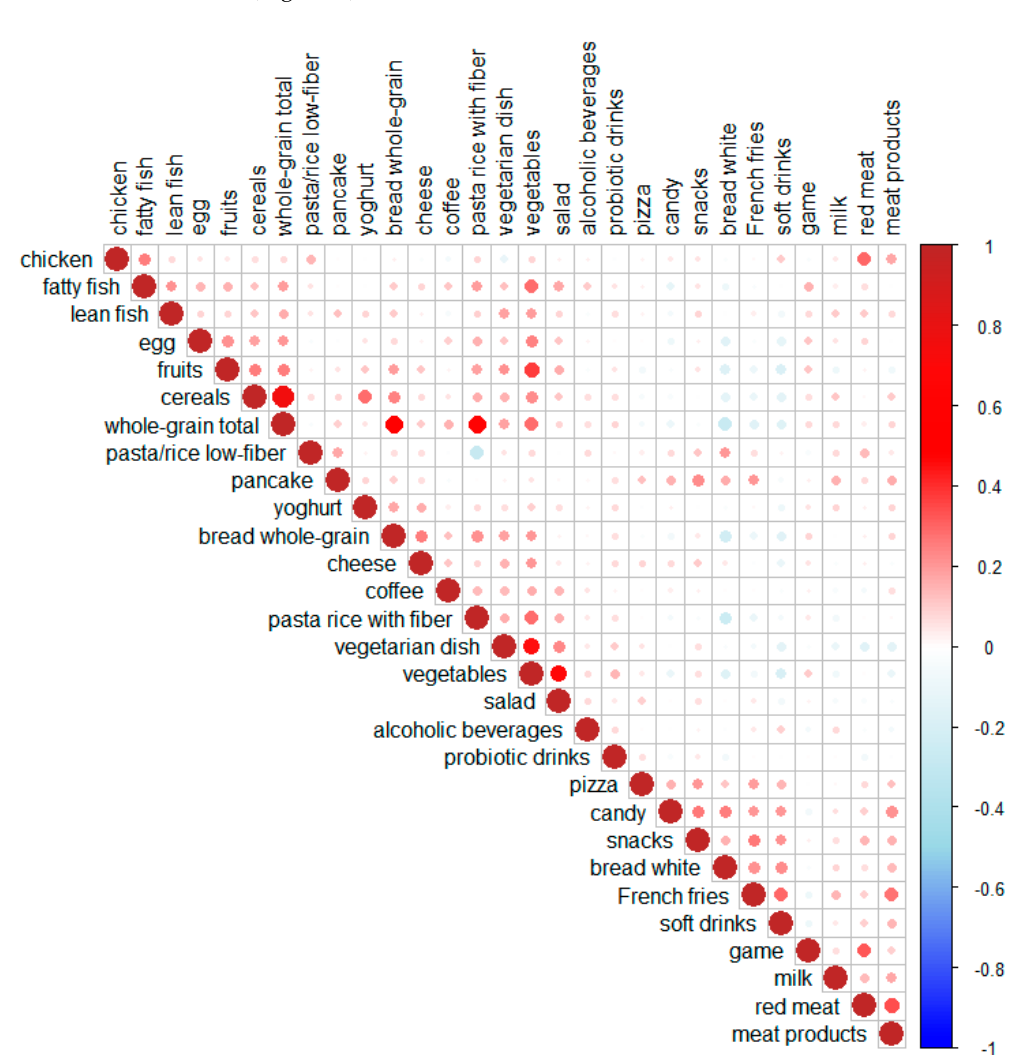
Figure 2. Correlation plot of food intake by all the subjects ( N = 567). The model groups together all the variables that are highly correlated and places them next to one another. The magnitude of the correlation is denoted with a color, whereby red indicates a positive correlation and blue denotes a negative correlation. The stronger the correlation, the darker is the color, and the larger is the dot.